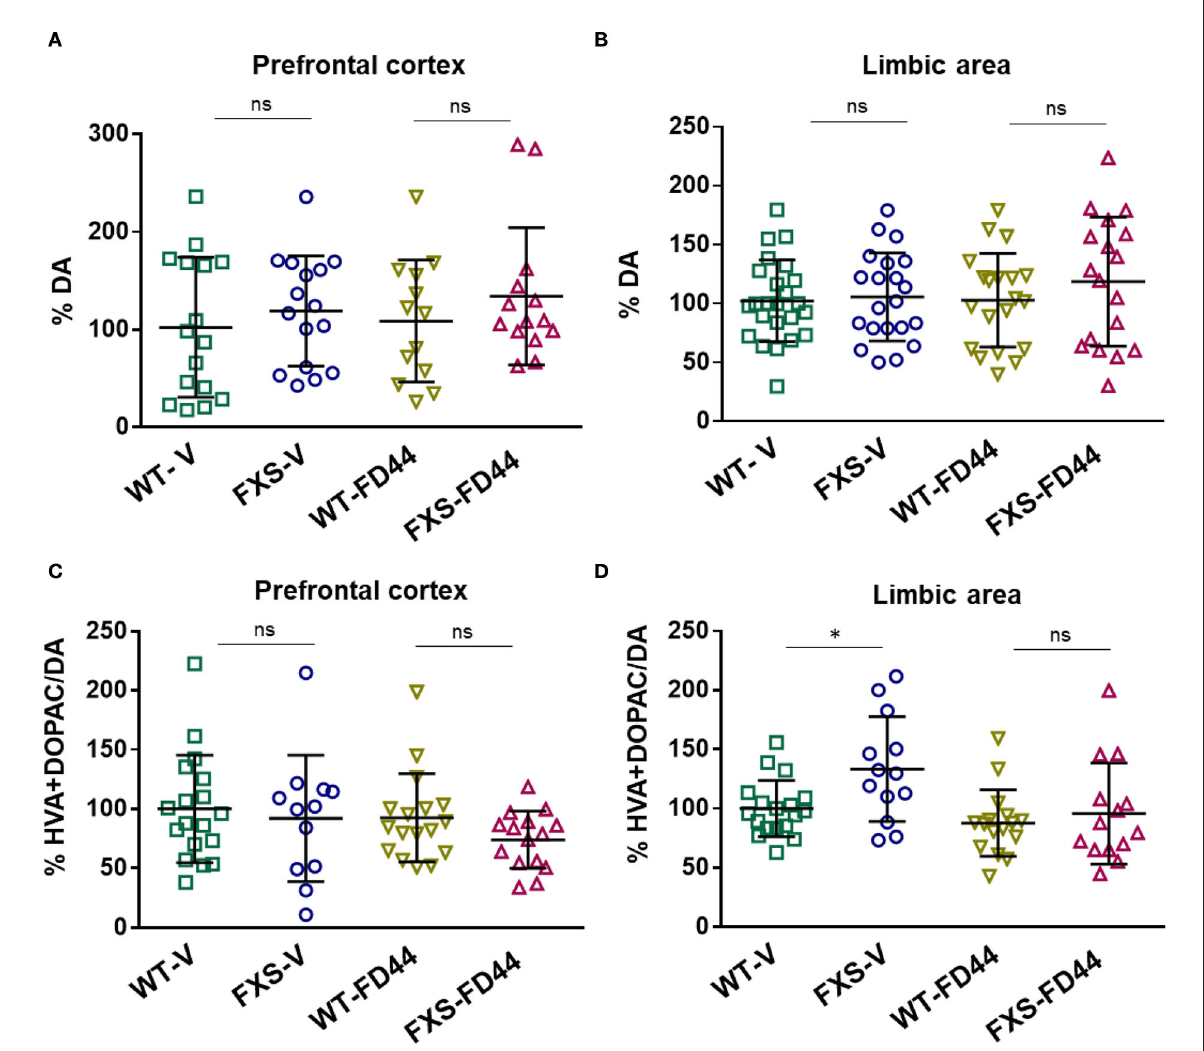
FIGURE5 Dopamine (DA) levels and DA metabolic rate in the brain areas of Fmr1 KO mice. The prefrontal cortex and limbic area were dissected from WT or Fmr1 KO (FXS) adult mice after treatment with V or with FD44 intraperitoneally for 4 weeks. The percentage of DA referred to WT-V as baseline condition in the (A) prefrontal cortex and (B) the limbic system. DA metabolism was shown as the percentage of 3,4-dihydroxyphenylacetic acid (DOPAC) and homovanillic acid (HVA) vs. DA in the (C) prefrontal cortex and (D) limbic system. Data were analyzed by one-way ANOVA followed by Bonferroni multiple pairwise comparison. n = 12-21. Each FXS group is compared to its WT counterpart, other comparisons were not relevant * p < 0.05, ns,